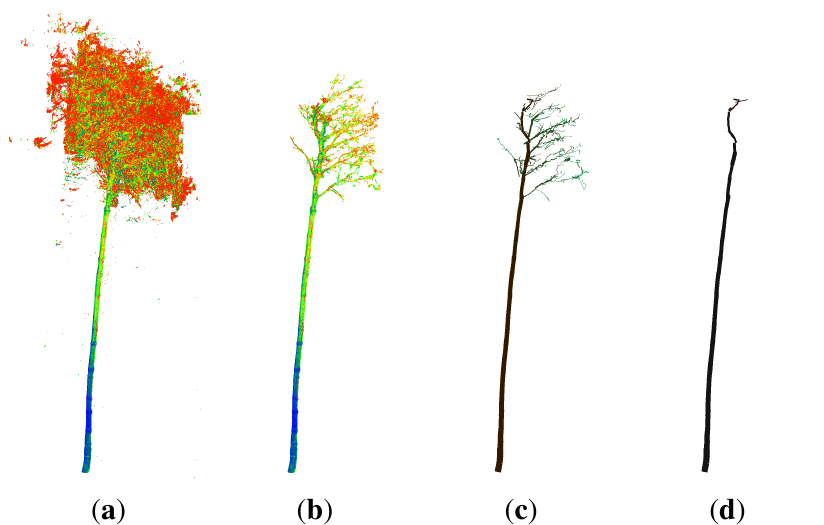
Figure 12. Processing the scan of a P. massoniana (P#10, height ≈ 16.4 m): (a) input point cloud containing a large number of ghost points; (b) the same cloud with ghost points and needle hits partially deleted; (c) the resulting cylinder model; (d) the extracted stem model.